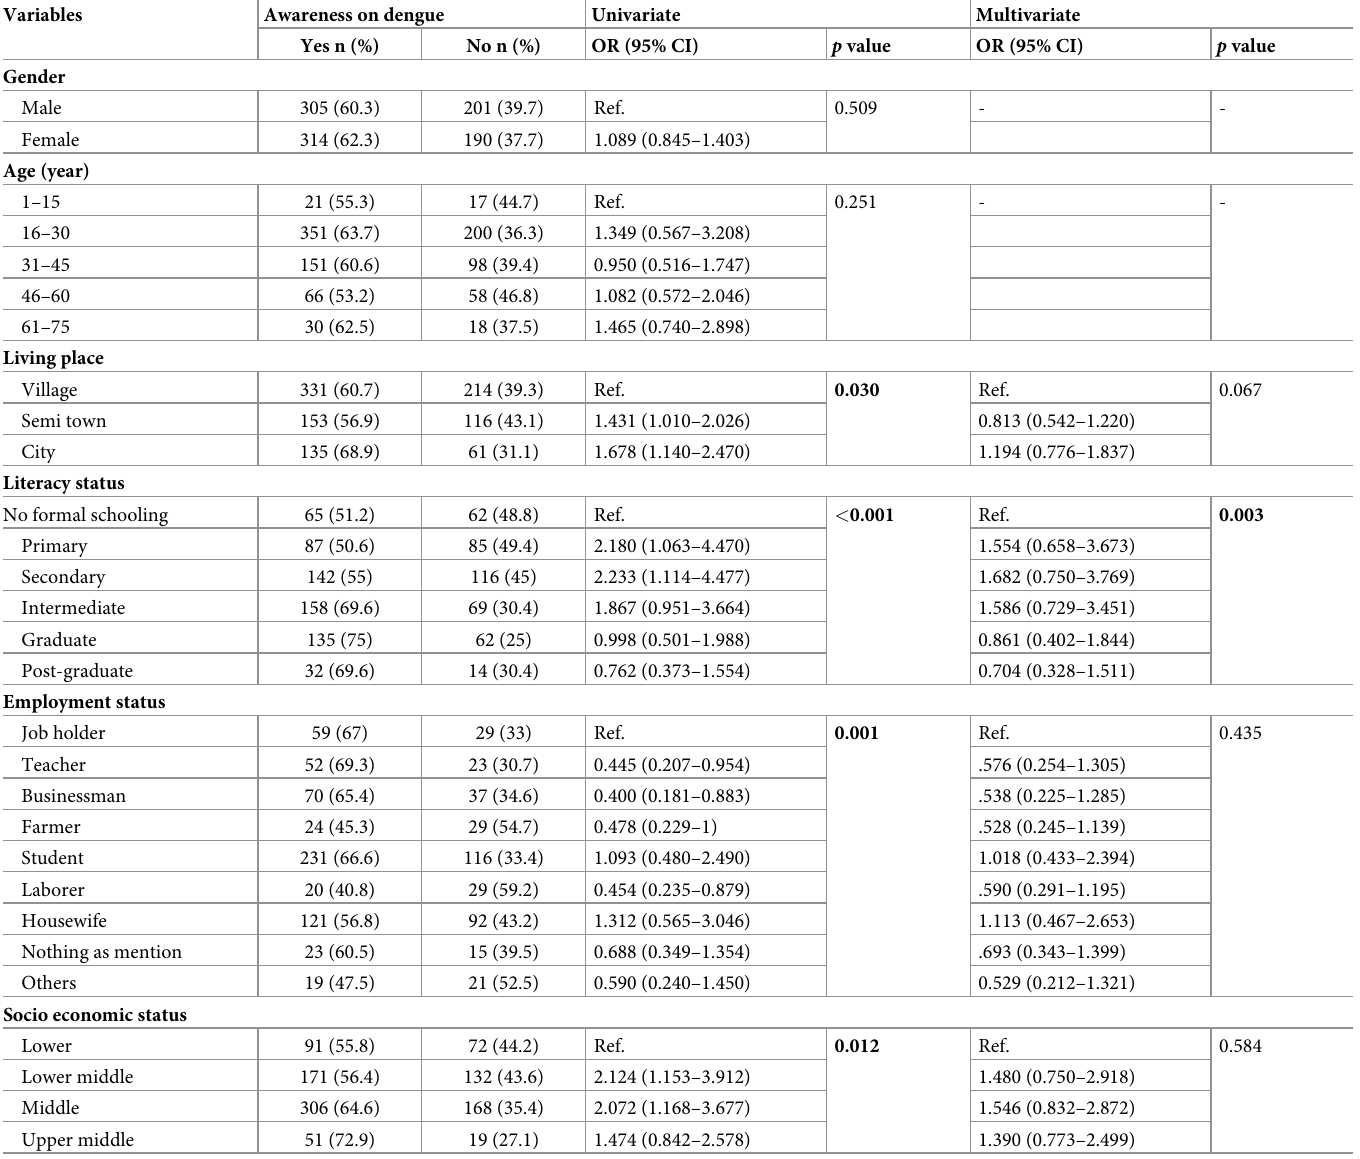
Table 5. Univariate and multivariable analyses of factors associated with awareness on dengue fever (Q-21). Variables Awareness on dengue Univariate